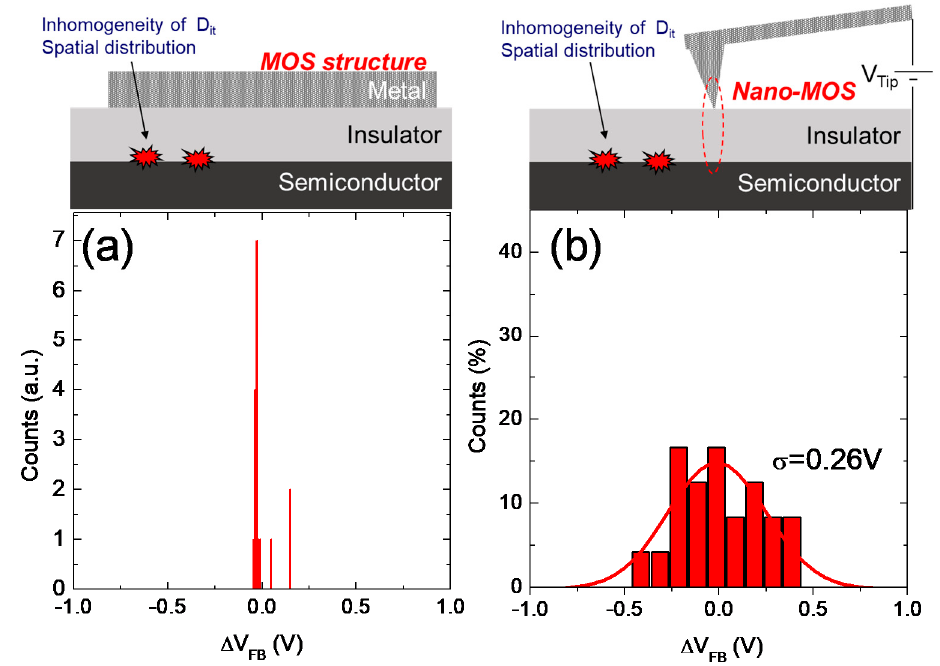
Figure 5. Dispersion of the flat band voltage shift ∆ V FB obtained from C–V measurements on 25 macroscopic MOS capacitors on a 6” wafer ( a ), and by scanning capacitance microscopy (SCM) measurements on arrays of 25 tip positions (with 1 µm spacing) ( b ).